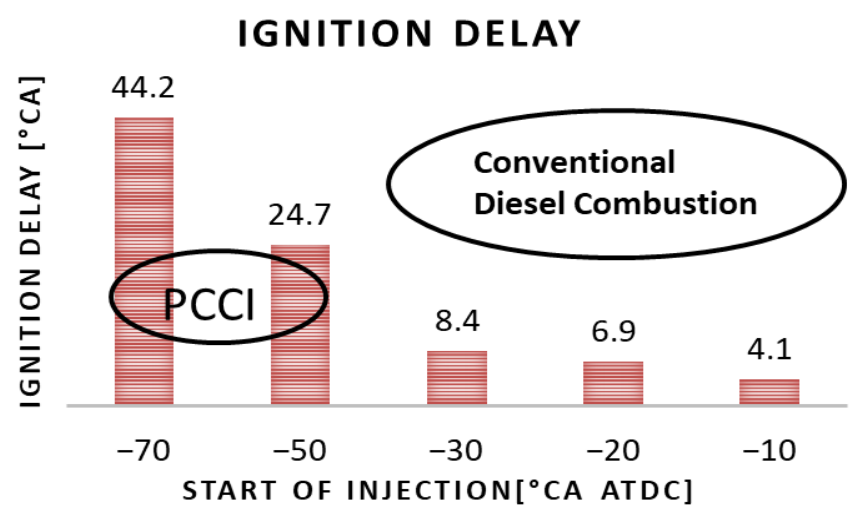
Figure 11. Effect of SOI timing on ID in °CA.